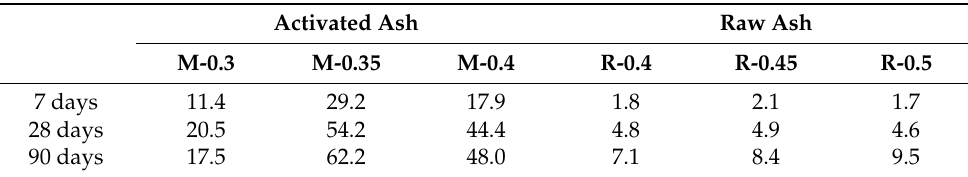
Table 2. Compressive strength (MPa) of the activated (M) and raw (R) ash mortars after 7, 28, and 90 days of curing. The value after the dash in sample name indicates the water/ash ratio. Activated Ash Raw Ash M-0.3